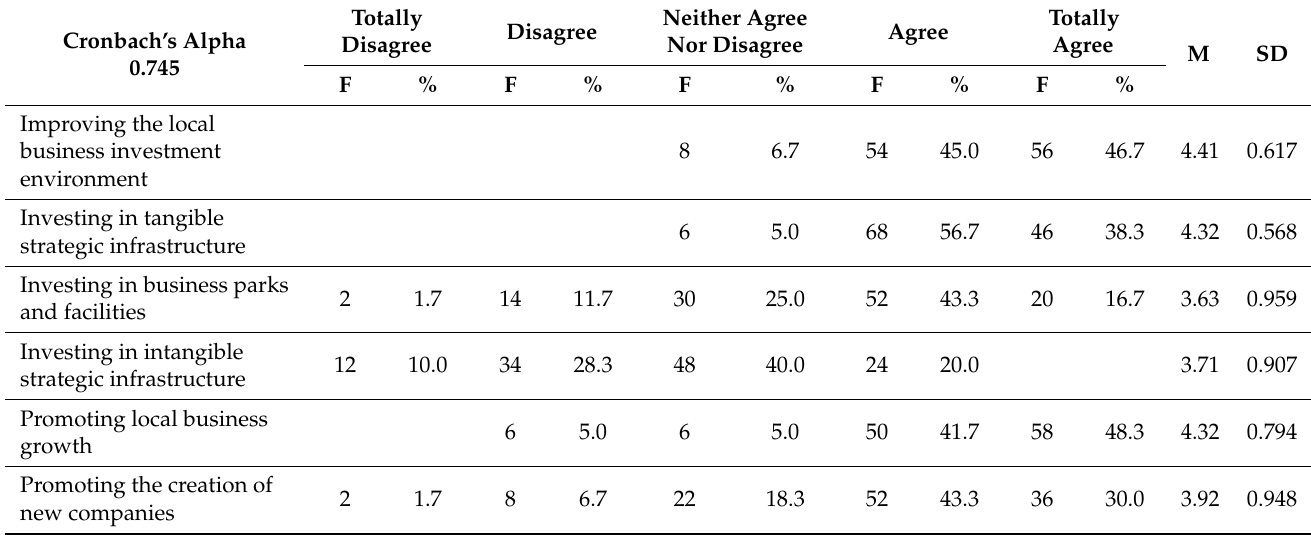
Table 4. Priority strategic goals for sustainable development and